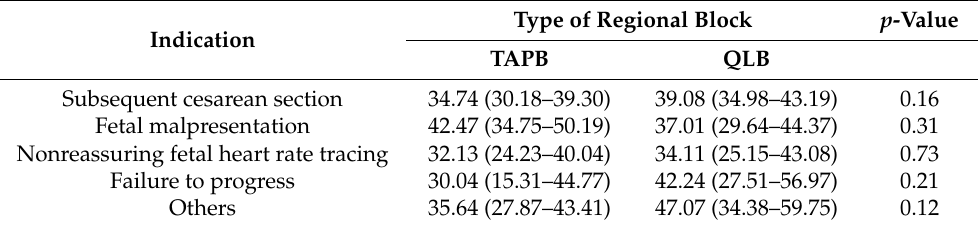
Table 5. Postoperative pain severity during the first 24 h after the surgery according to indications for cesarean section and type of regional